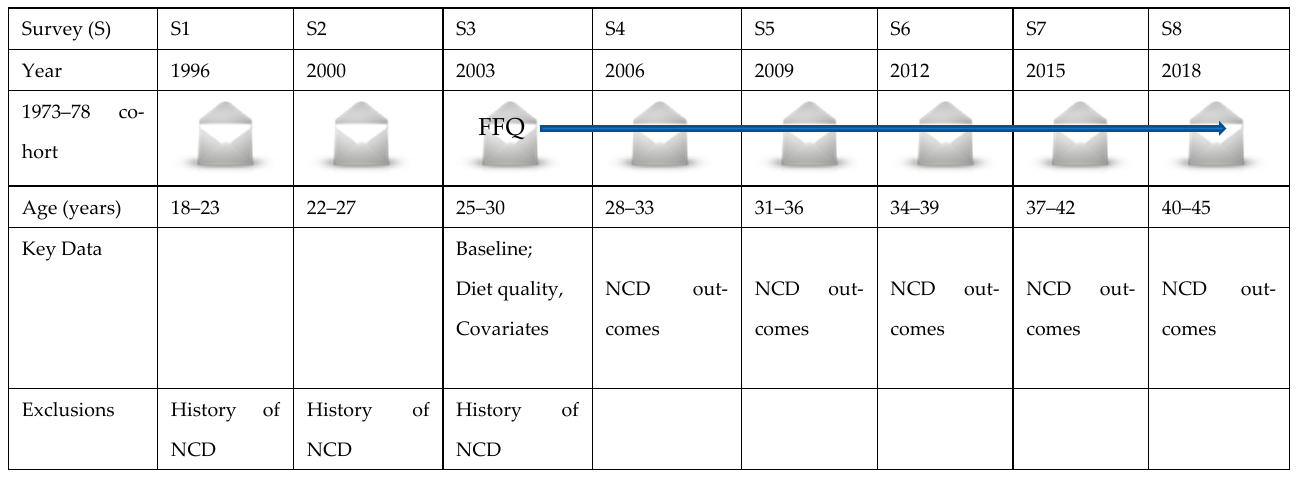
Figure 1. Simplified diagram showing women born between 1973 and 1978 in the Australian Longitudinal Study on Women’s Health (ALSWH).